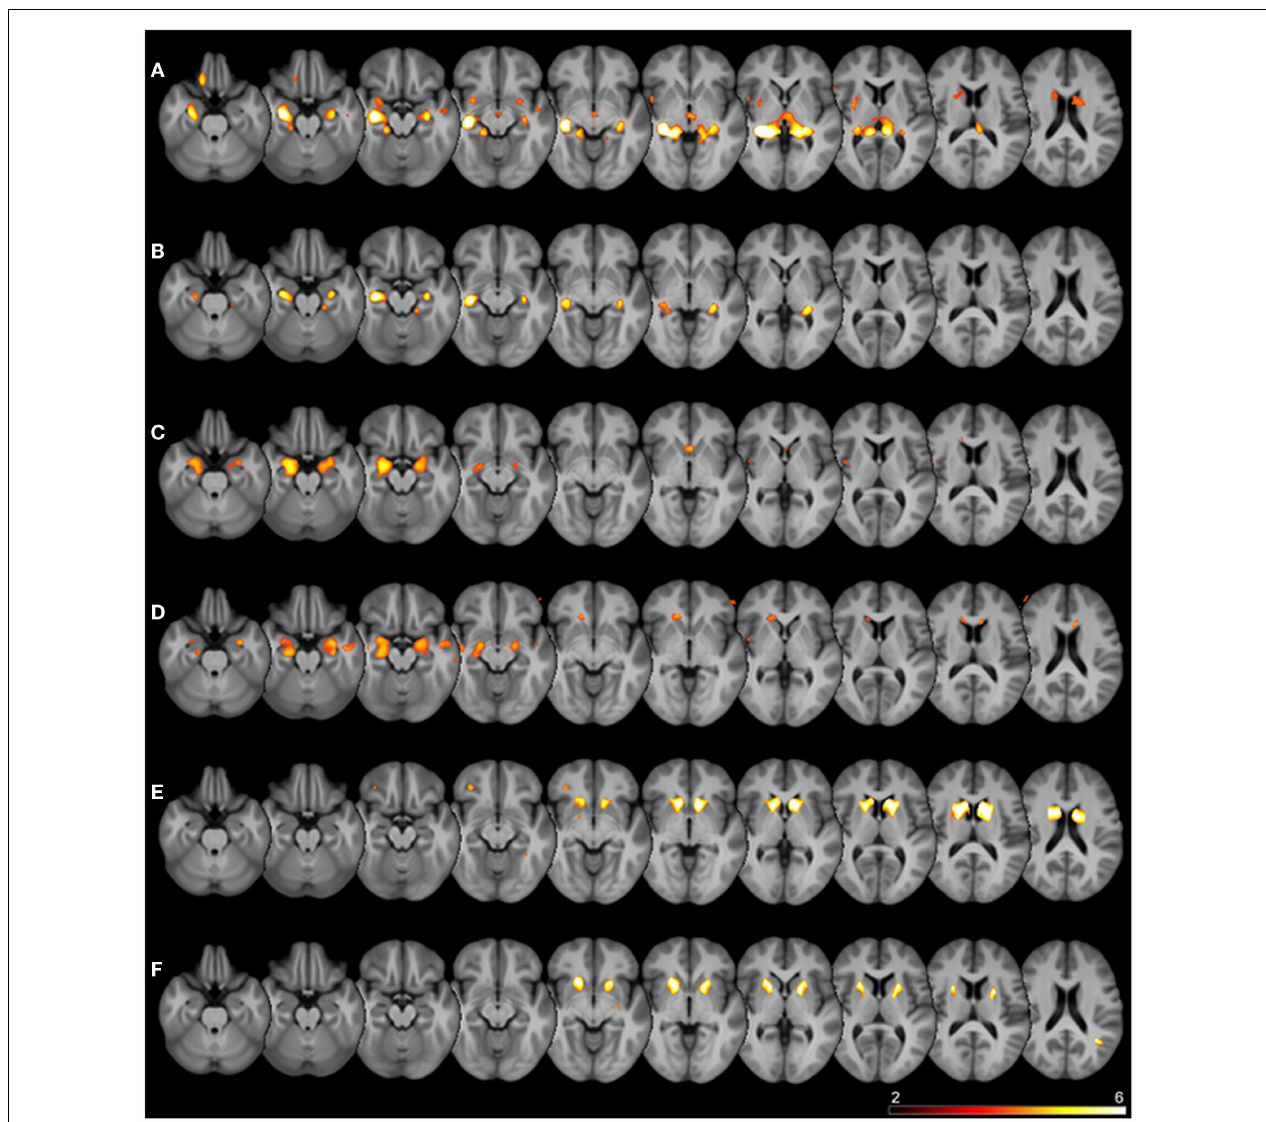
are in radiological convention (left in image is right in the subject). Rows are different seed regions: (A) left hippocampus, (B) right hippocampus, (C) left amygdala, (D) right amygdala, (E) left caudate nucleus, (F) left